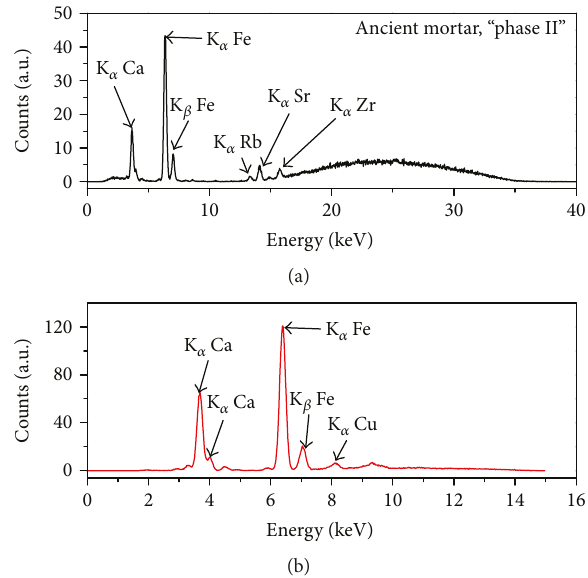
Figure 6: XRF spectra, in the 0 – 40keV range (a) and 0 – 16 keV range (b), of an ancient mortar of “ phase II.